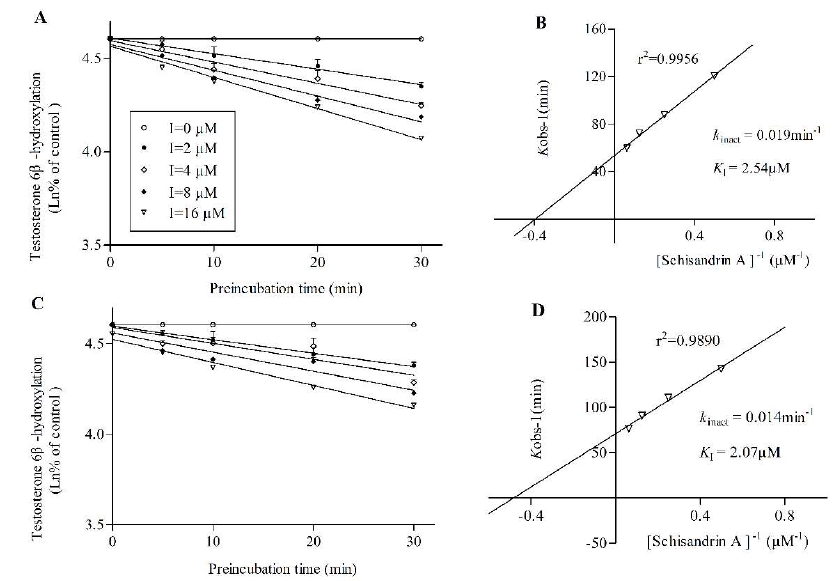
Figure 4. Inactivation of CYP3A4 ( A and B ) and CYP3A5 ( C and D ) activity by SIA. Various con- centrations of SIA (0, 2, 4, 8, 16 μM) and NADPH at were preincubated at 37 ° C for 0, 5, 10, 20 and 30 min in 0.1M PBS). ( A and C ) a plot of the log of percentage of control activity versus pre-incu- bation time. ( B and D ) a plot of the half-life of enzyme inactivation versus the inverse of the SIA concentration. Each point represents the mean of triplicate experiments (mean and SD values are listed in Table S1).